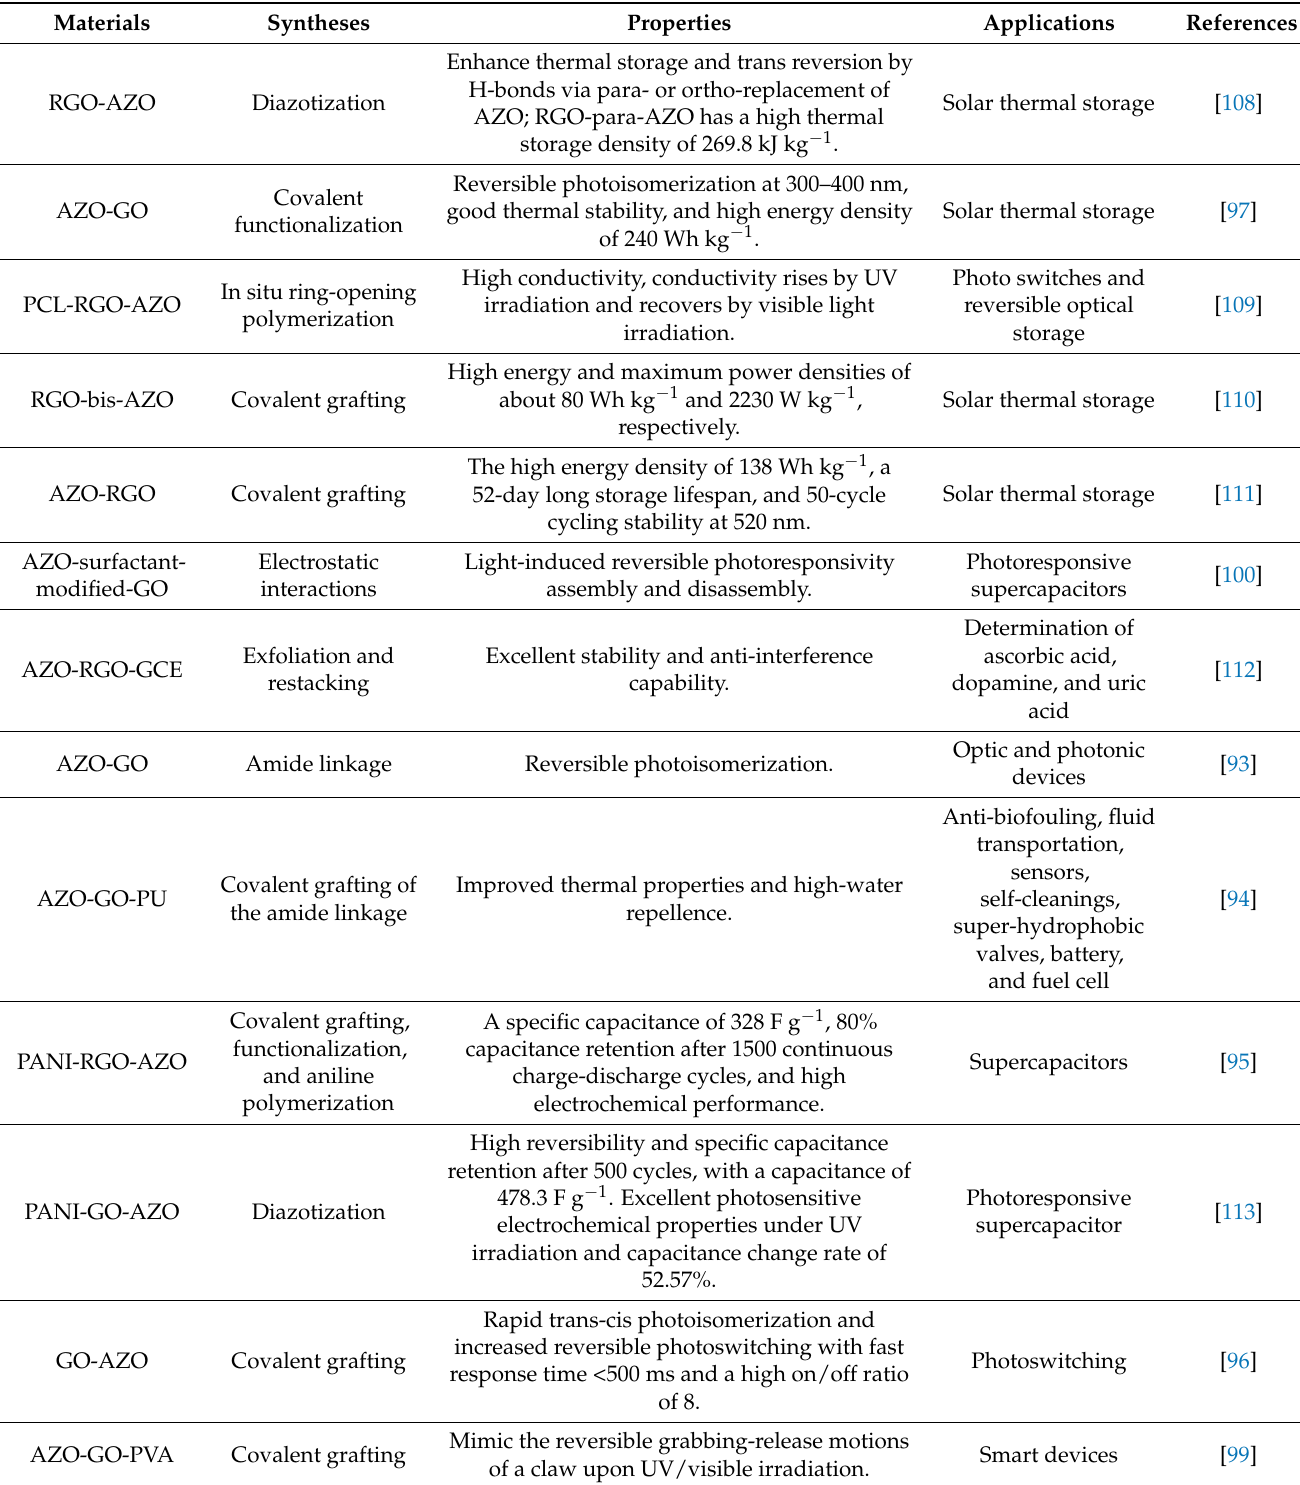
Table 1. Synthesis, properties, and applications of AZO-grafted GO